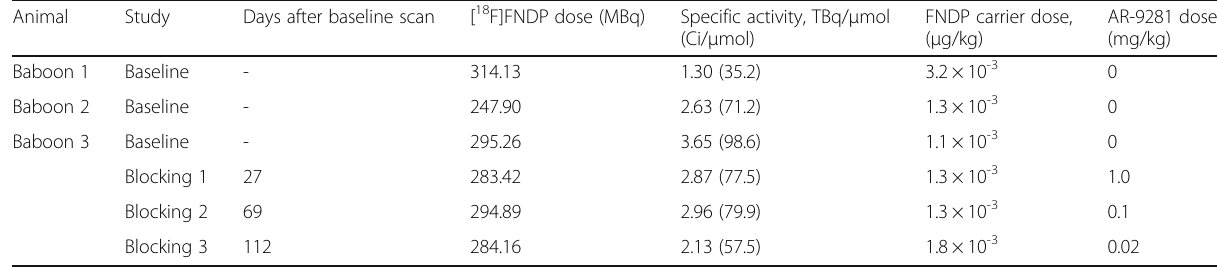
Table 1 Experimental information for [ 18 F]FNDP PET scans (baseline and blocking) in baboons Animal